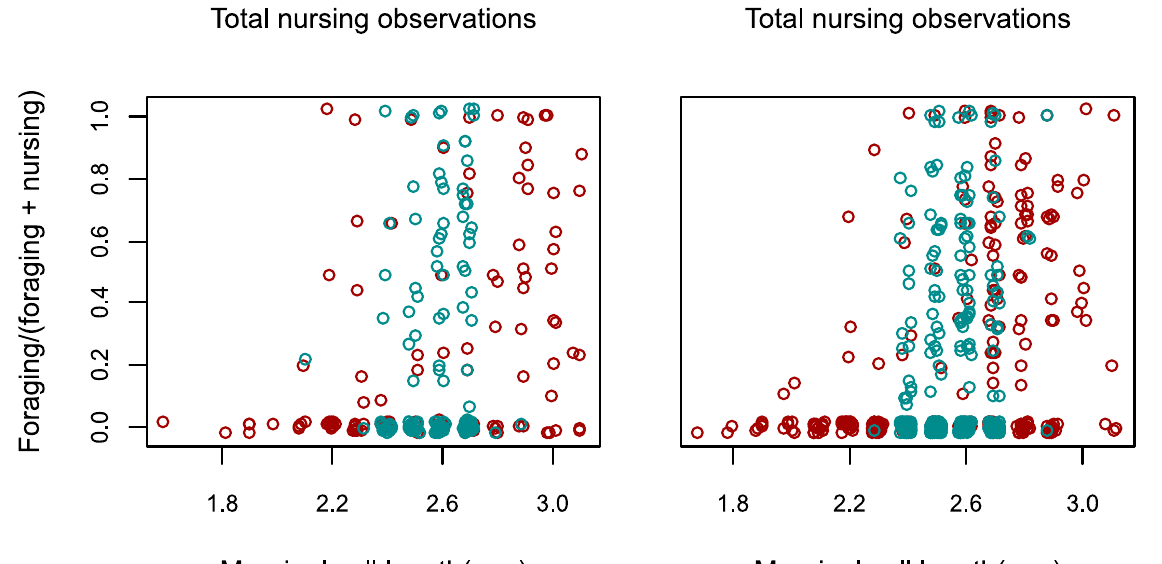
Figure 5. Body sizes of worker roles in size-diverse and -homogeneous colonies. Shown separately for Trial 1 (left) and Trial 2 (right). Workers categorised as foragers, nurses or intermediate, based on task activity frequencies (see Methods